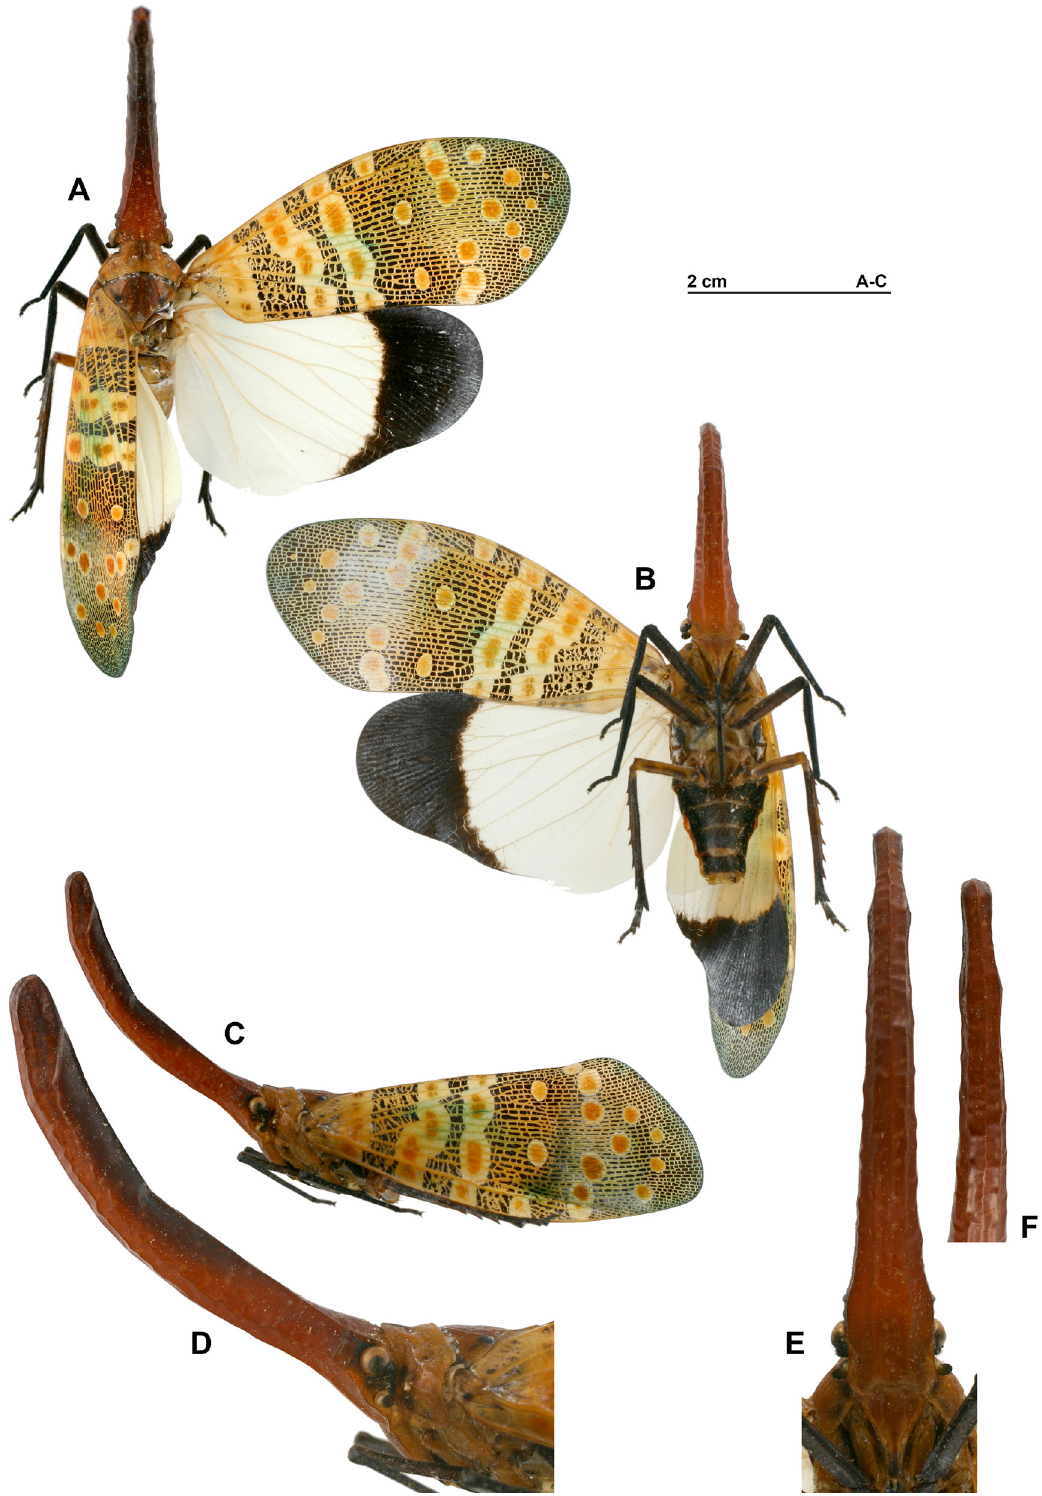
Fig. 19. Pyrops vitalisius (Distant, 1918), ♂, Vietnam, Ninh Binh Prov., Cuc Phuong N.P., 11–18 Jul. 2010 (RBINS). A . Habitus, dorsal view. B . Habitus, ventral view. C . Habitus, lateral view. D . Head and thorax, lateral view. E . Head, perpendicular view of frons. F . Apex of cephalic process, anteroventral view. D–F = not to